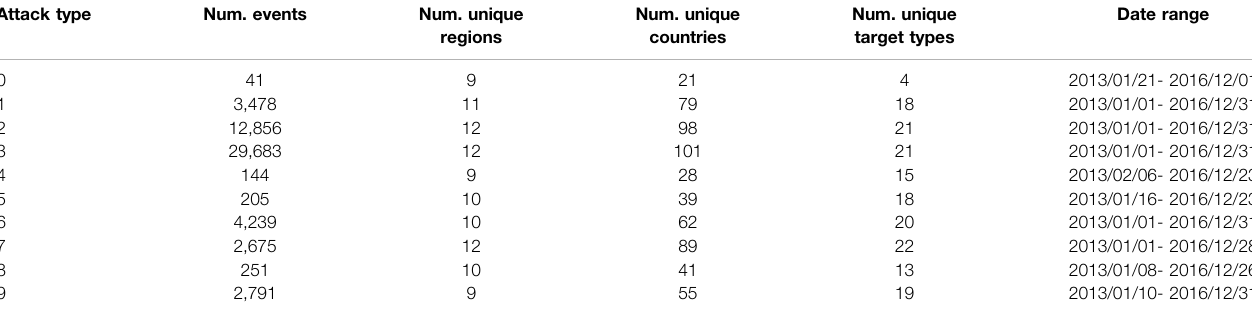
TABLE 1 | A pro fi le of GTD events, categorized by attack types. The number in the fi rst column is an attack type code; see Table 2 for the codebook. Attack type